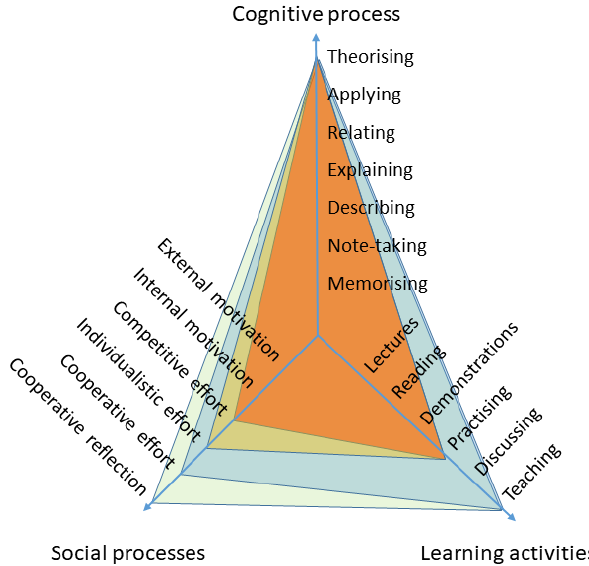
Figure 3: Competitive, individualistic, and cooperative learning